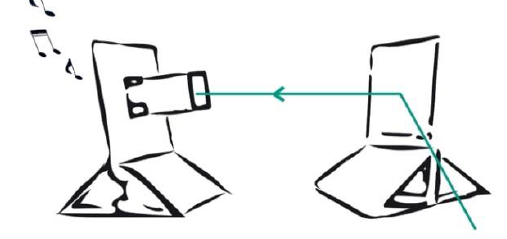
Figure 10 Mirror, sensor and the base and their function